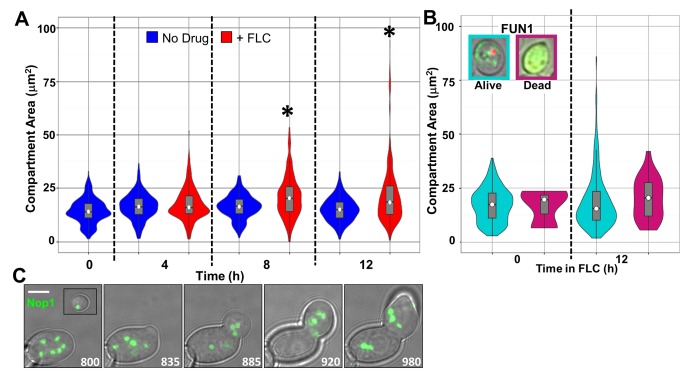
Abnormally large cells are viable.(A) Violin plots (area indicates frequency along the y-axis) overlaid with box plots (gray) showing the distribution of cell sizes (see Materials and Methods). “No drug” control cultures (blue) show no significant changes in cell size distribution over time. FLC-exposed cultures (red) show a significant cell size increase at 8 and 12 h of FLC exposure (two-tailed t test, p value <0.05). (B) Violin plots, as above, showing size distribution of metabolically active (cyan, alive) and inactive (magenta, dead) cells as determined by FUN1 staining interpreted as shown in the micrograph insets. (C) Abnormally large cells with multiple nucleoli (detected with Nop1-GFP, green) continued to grow, produced new buds, and underwent unusual nucleolar segregation patterns. Inset in first panel is an unbudded cell from a “no drug” control shown on the same size scale. Scale bar, 5 µm.